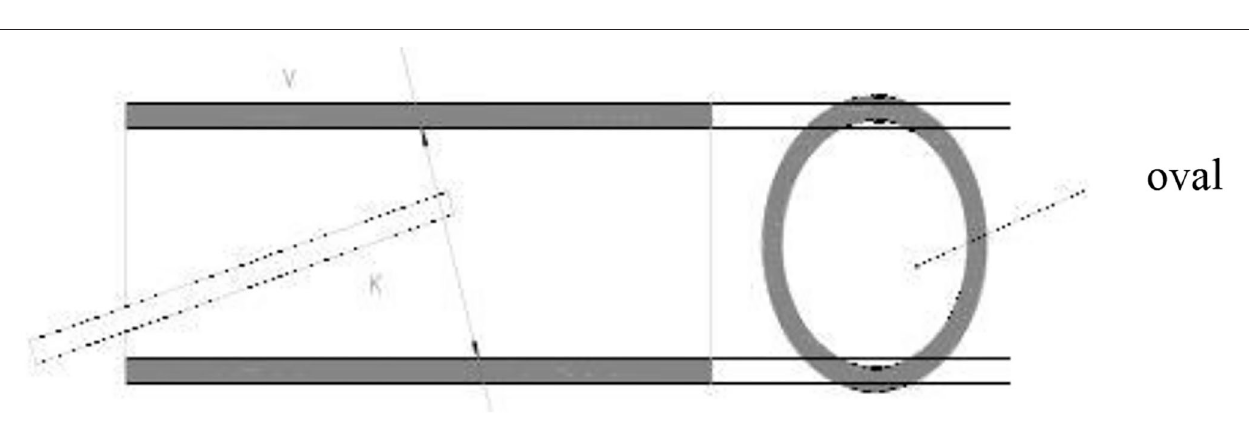
FIGURE 4 | Ultrasound catheter in the non-central position of the blood vessel.